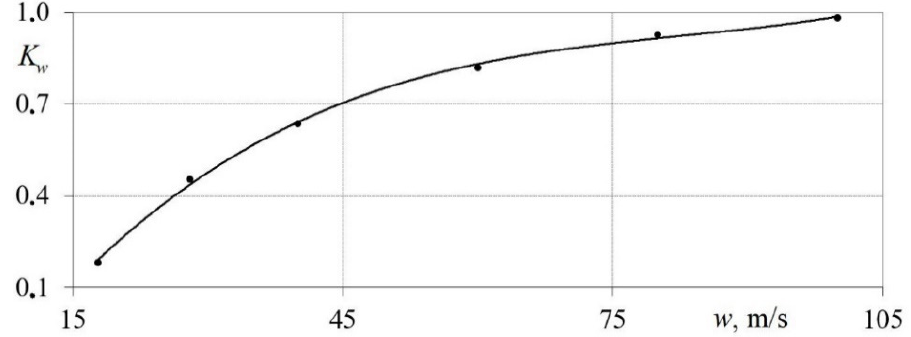
Figure 11. Dependence of the waveform conformance factor K w on the average air flow velocity w .